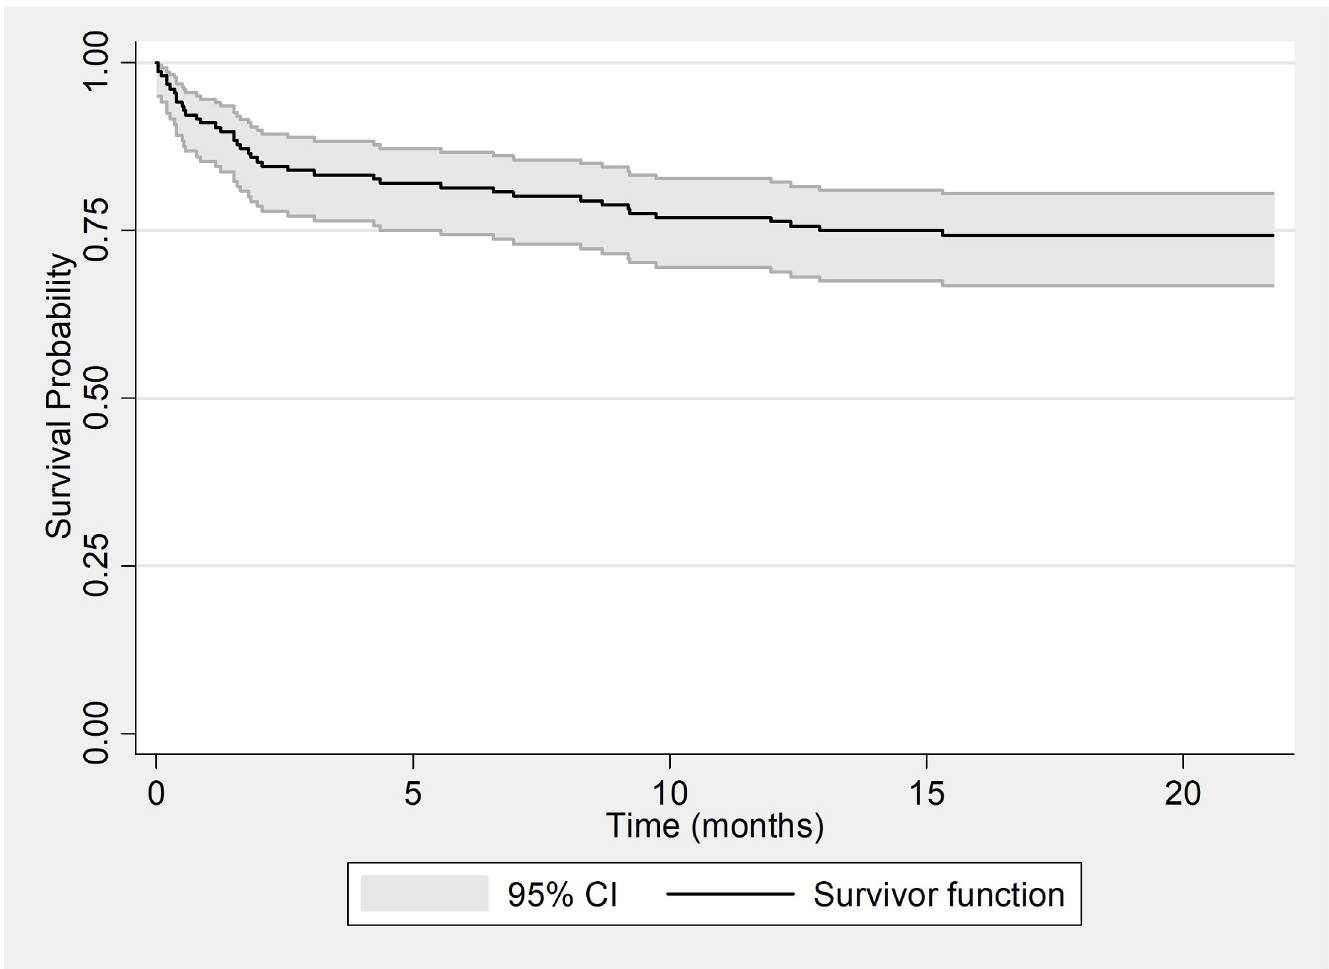
Fig 3. Kaplan-Meier survival estimates for unfavorable outcomes among HIV positive patients.